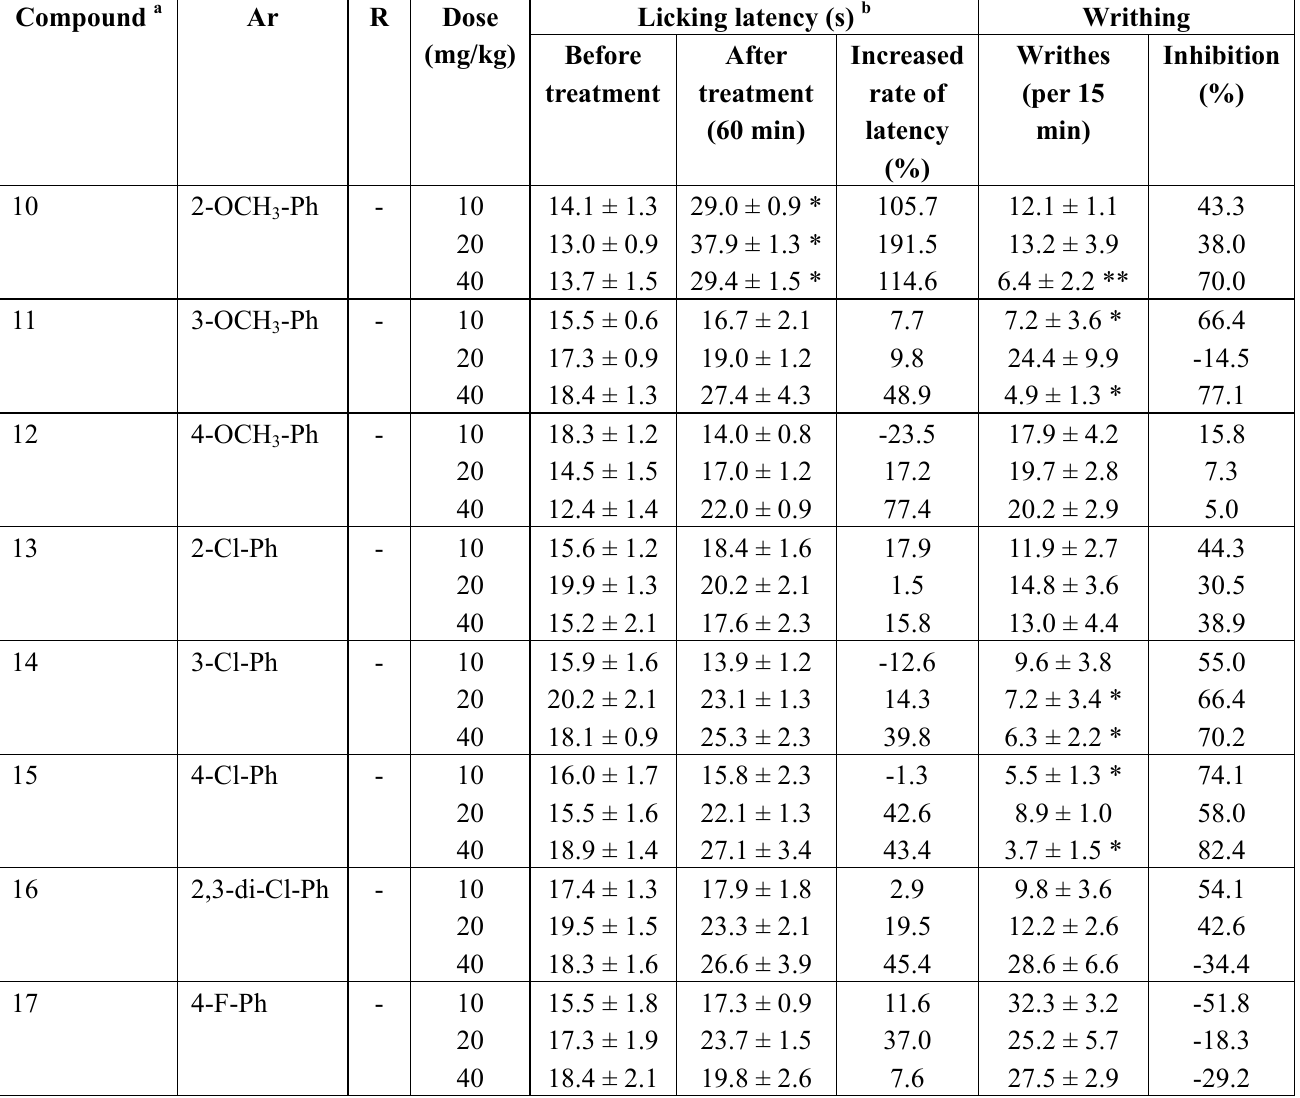
Table 1. Antinociceptive effect of final compounds in the writhing test and hot plate test. Compound